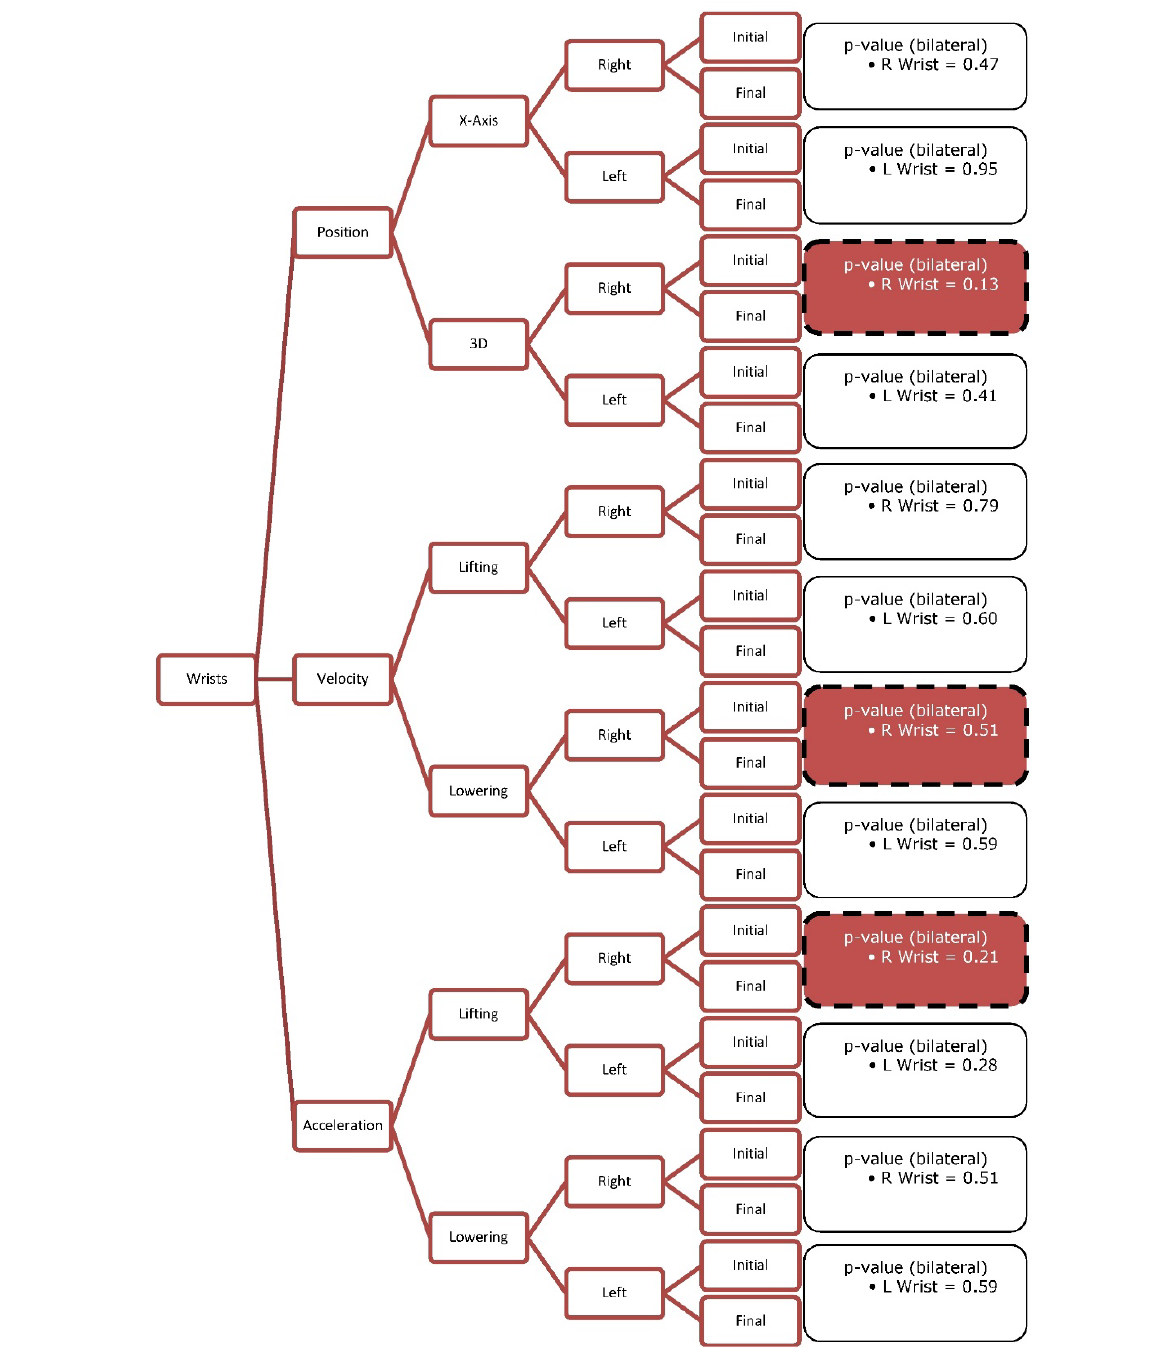
Figure 8. Wrists student's paired t-test